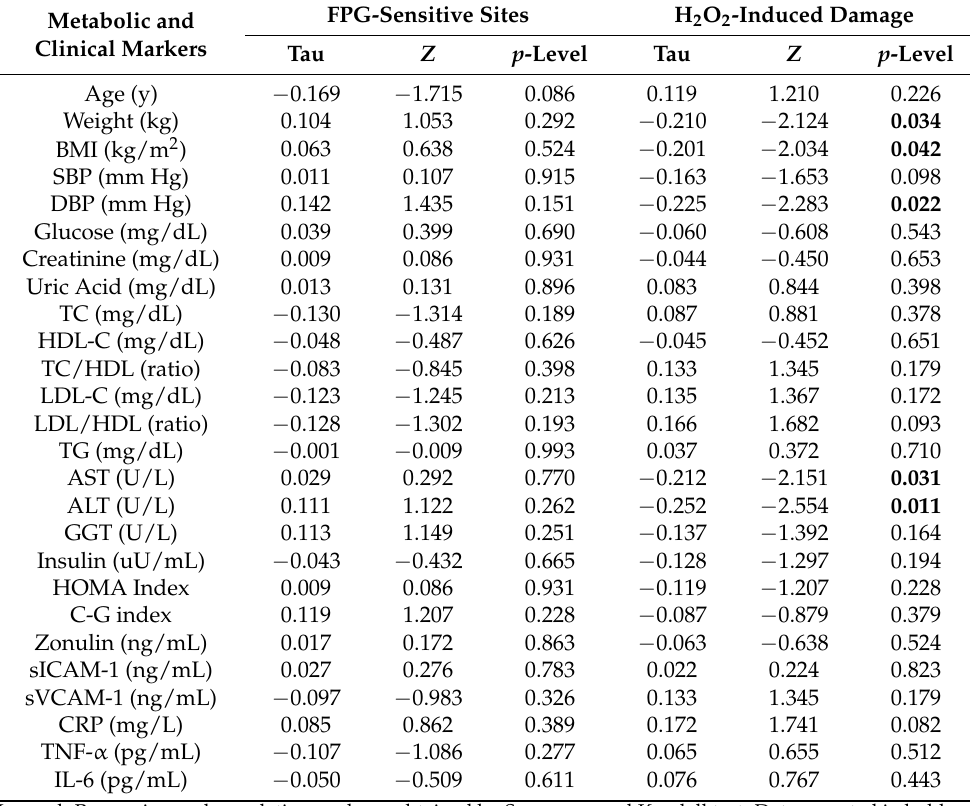
Table 4. Correlation analysis between anthropometric, metabolic and clinical markers and DNA damage in the whole group of